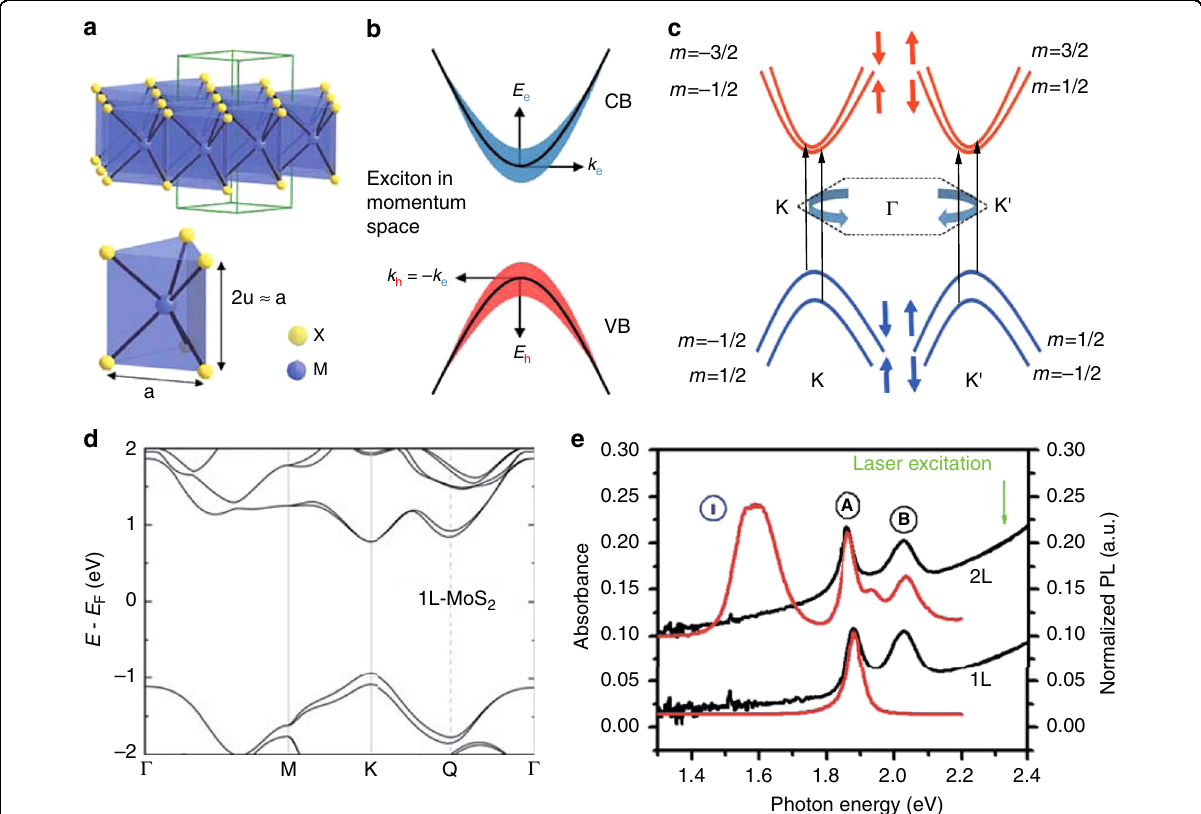
Fig. 1 Crystal and electronic band structures, and PL and absorption spectra of unstrained 2D TMDCs. a Schematic of the crystal structure of monolayer MX 2 (ref. 14 ). b Schematic of an exciton in reciprocal space formed via the Coulomb attraction between an electron in the conduction band (CB) and a hole in the valence band (VB) 62 . c Electronic bands around the K and K ′ points of MX 2 showing spin – orbit coupling-induced energy splitting. d Band structure of monolayer (1L) MoS 2 obtained from DFT calculations considering spin – orbit coupling 14 . e Absorption spectra (black lines, normalized by the number of layers) and corresponding PL spectra (red lines, normalized by the intensity of peak A) of monolayer (1L) and bilayer (2L) MoS 2 (ref. 12 ). Reprinted a and d from ref. 14 with permission from Wiley. Reprinted b with permission from ref. 62 . Copyright (2018) by the American Physical Society. Reprinted e with permission from ref. 12 . Copyright (2010) by the American Physical